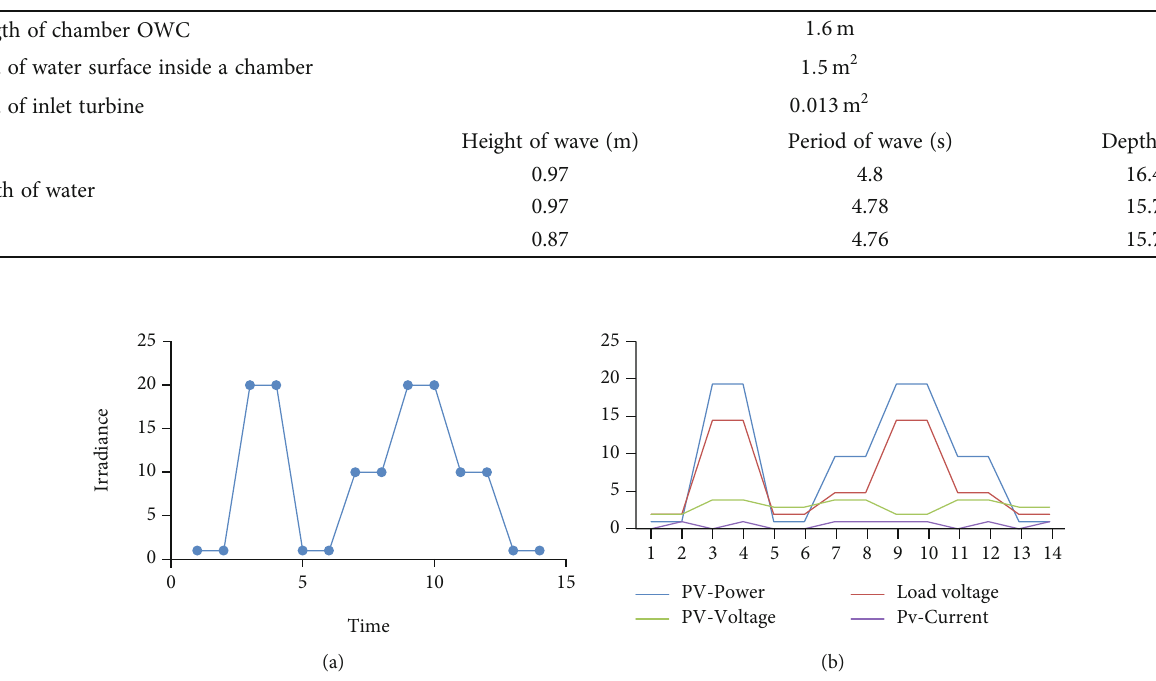
Figure 8: (a) An illumination pro fi le of MPPT. (b) Matching